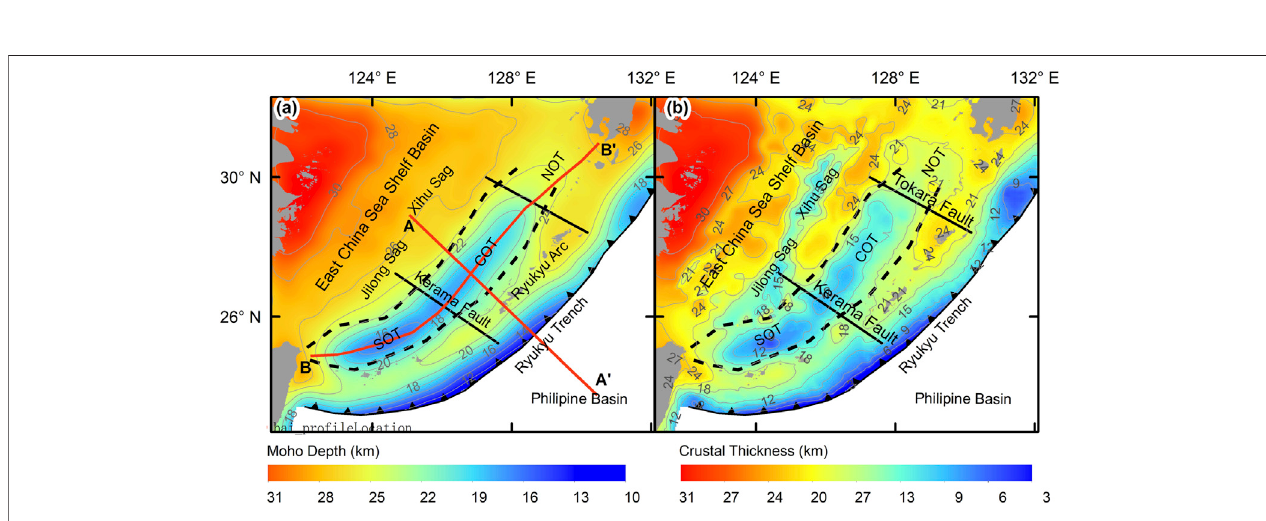
FIGURE 5 | Moho depths (A) determined from gravity inversion and crustal thickness (B) , which is obtained by subtracting the sea water depth and sediment thickness from the Moho depth. The red thick lines in the left panel represent the locations of the pro fi les in Figure 7 and Figure 8 .